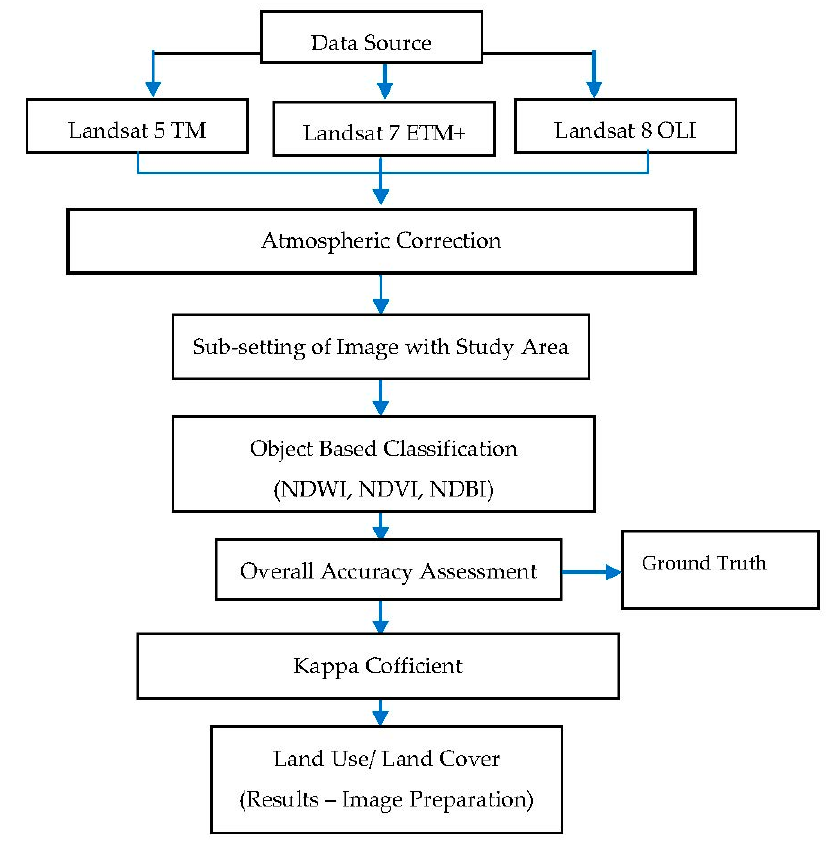
Figure 2. Flow chart of materials and methods. Table 1. Detail extracted from satellite imagery for land surface temperature (LST) from 1990–2016.